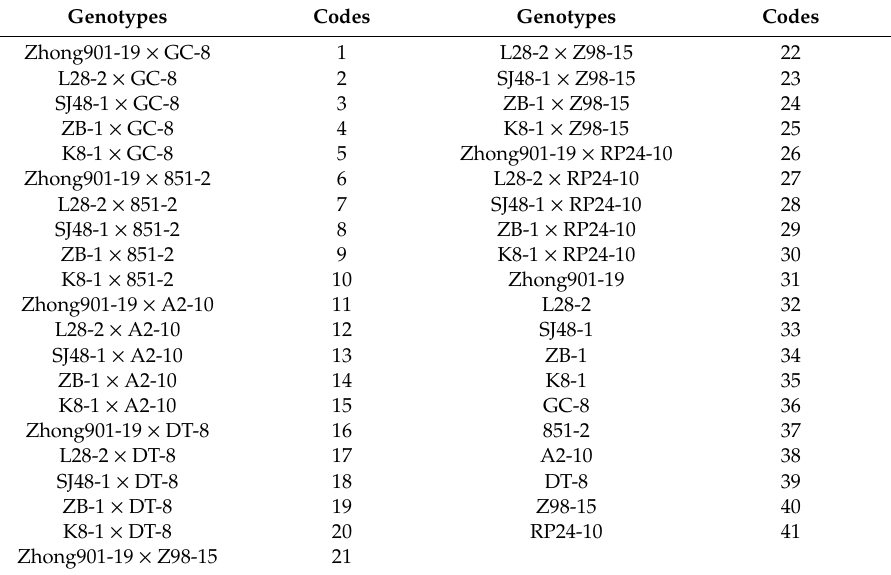
Table 1. Name and code of 41 cotton genotypes evaluated in this study.